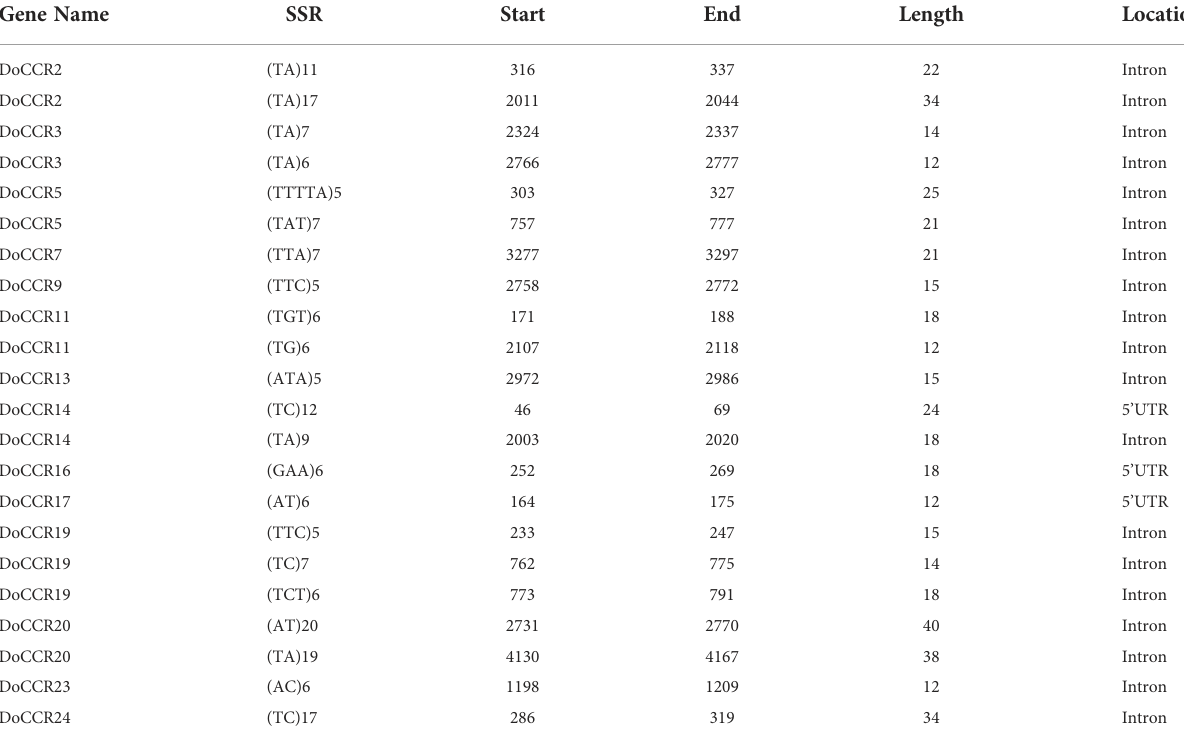
TABLE 2 The SSR loci in DoCCR genes (excluding mononucleotide